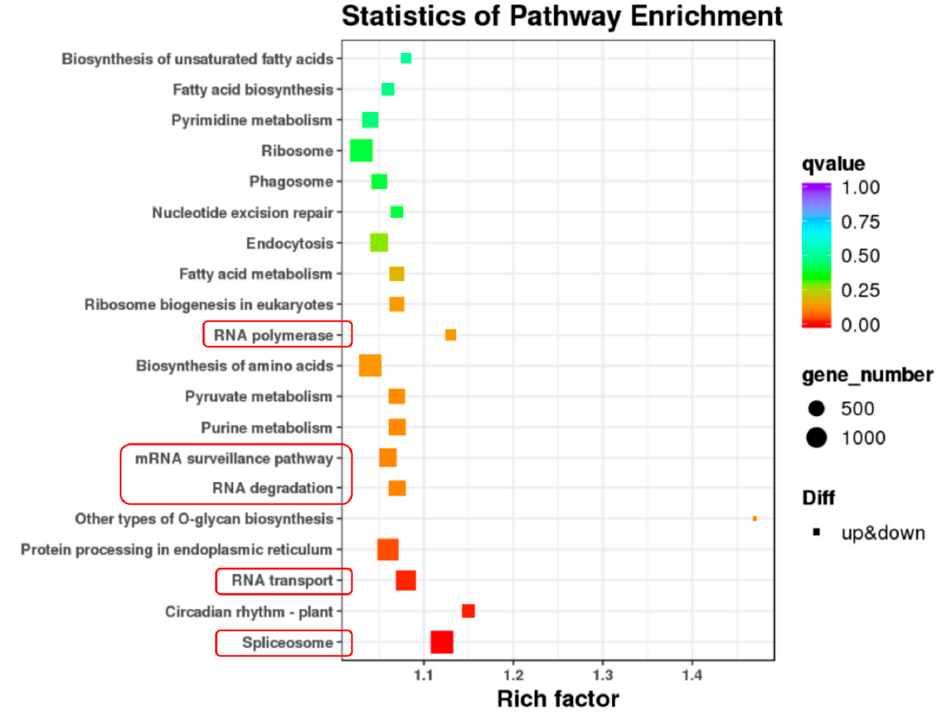
Figure 2. KEGG enrichment analysis of differentially expressed genes. KEGG enrichment of DEGs between A. latifolia and A. eriantha . The pathways of RNA spliceosome, transport, degradation, surveillance pathway, and polymerase were highlighted by red frames.